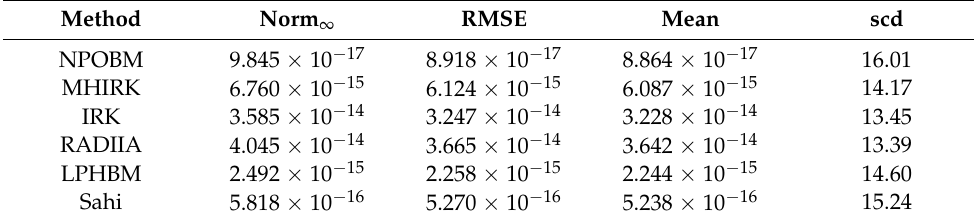
Table 5. Numerical results for Problem 2 with NS = 2 6 where x ∈ [ 0,5 ] .